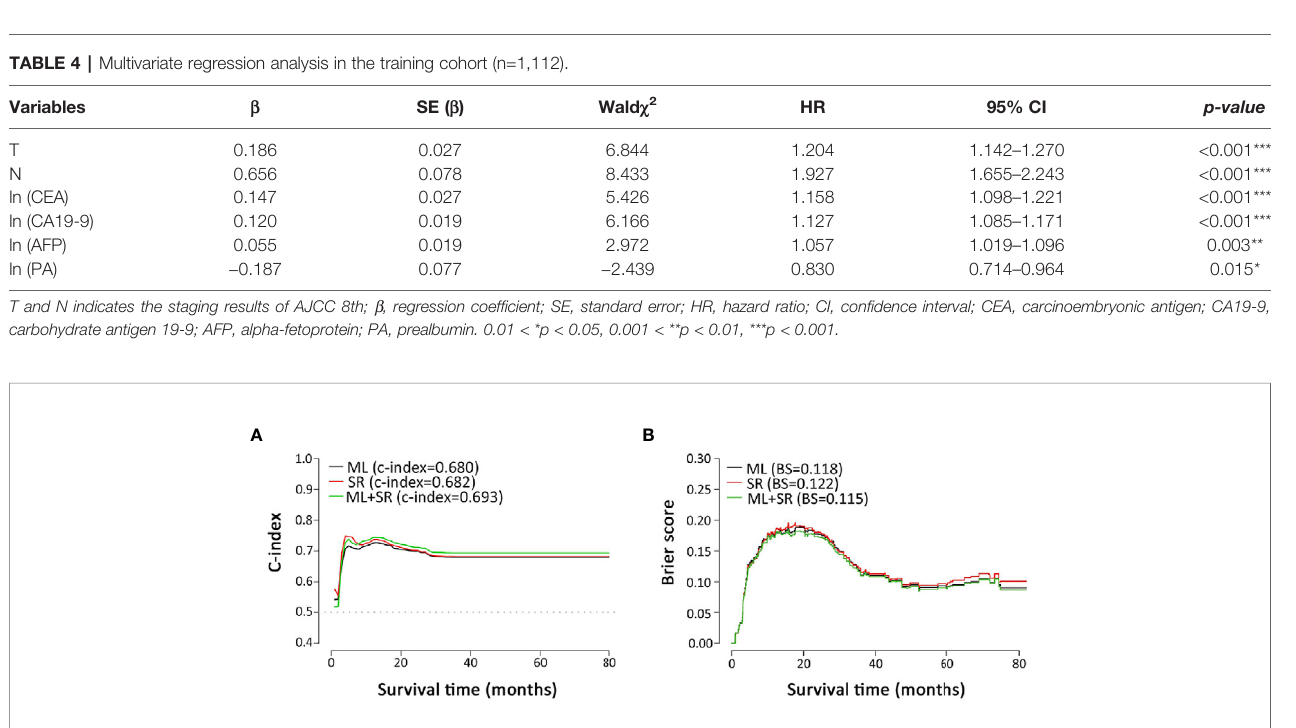
T and N indicates the staging results of AJCC 8th; IQR, interquartile range; CA19-9, carbohydrate antigen 19-9; g -GT, g -glutamyltranspeptidase; Alb, albumin; ALT, alanine aminotransferase; ALP, alkaline phosphatase; PA, prealbumin; AST, aspartate aminotransferase; CEA, carcinoembryonic antigen; AFP, alpha-fetoprotein; DBIL, direct bilirubin; TBIL, total bilirubin. *p <